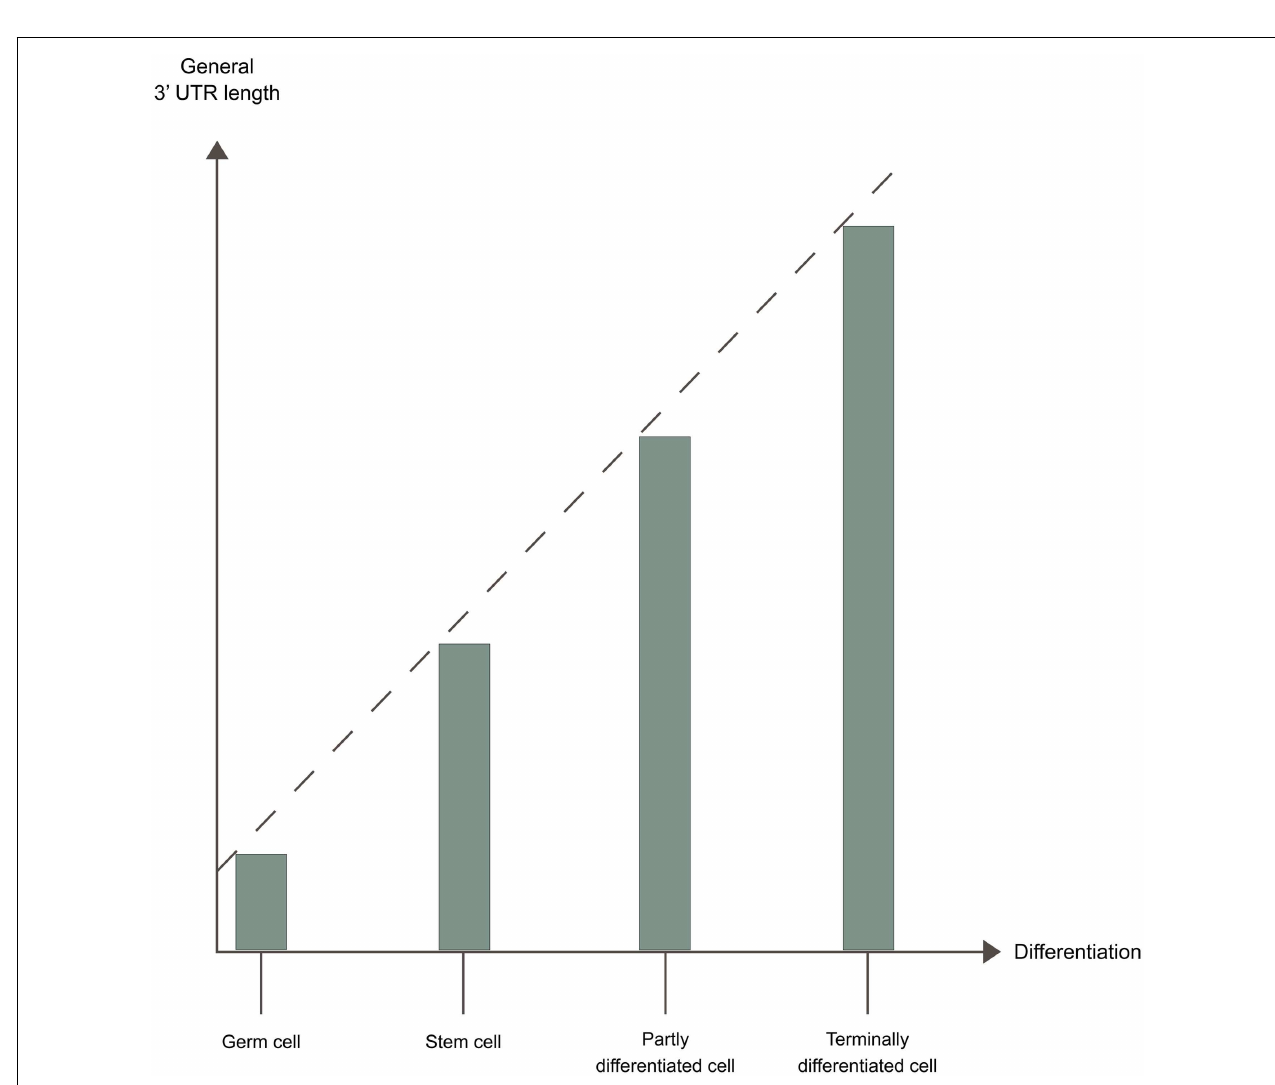
FIGURE 4 | 3 (cid:48) UTR length and developmental potential .The developmental potency of a cell seems to be inversely correlated to 3 (cid:48) UTR length.The 3 (cid:48) UTR is shortest in germ cells < stem cells < partly differentiated cells < terminally differentiated cells, due to different APA patterns in these cells.